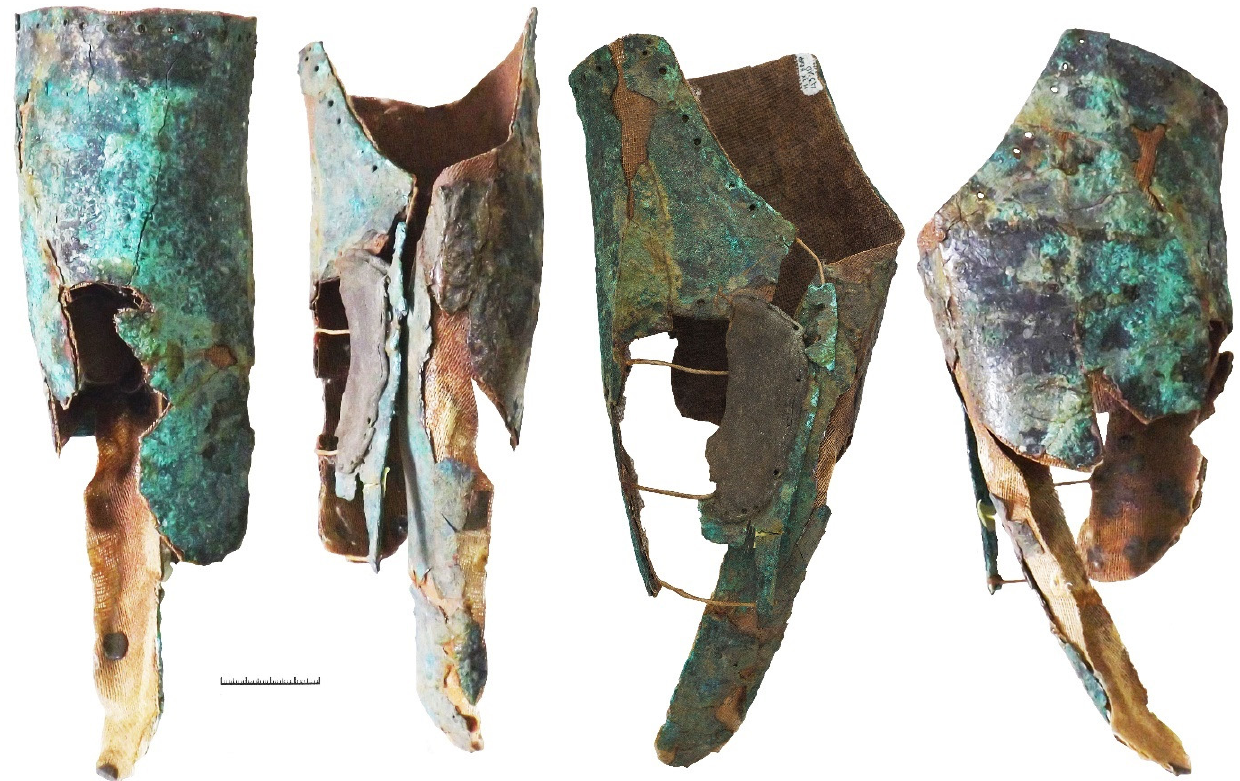
Figure 7. Vodoslavka Barrow 6 Burials 1–2. The right greave (photograph T. Shelemeteva).